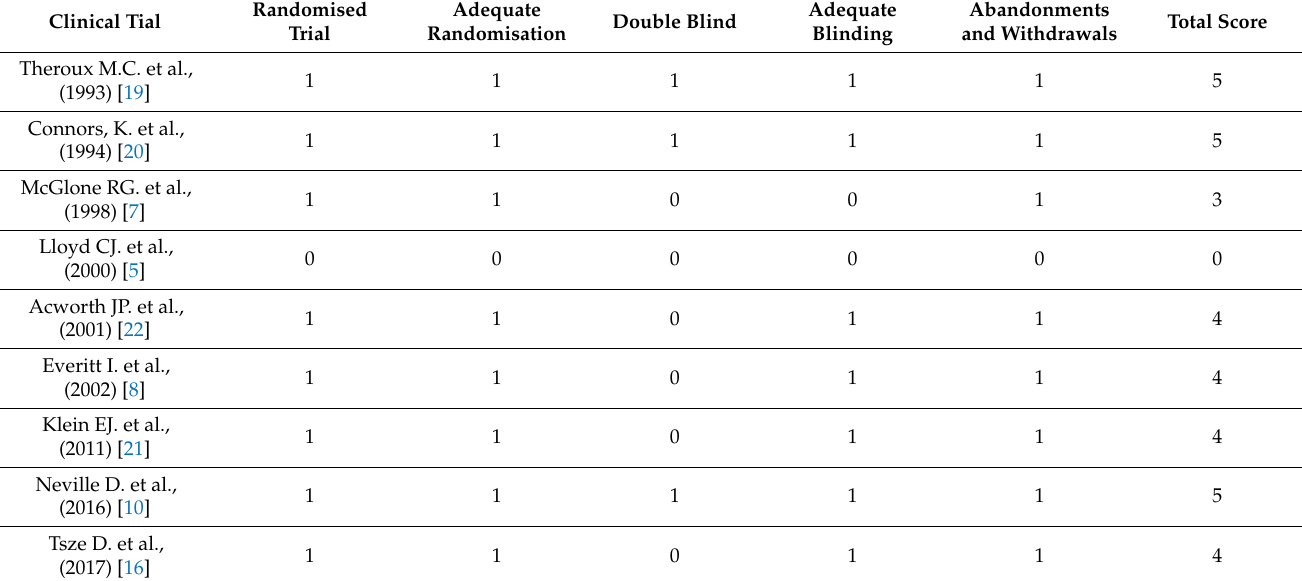
Table 4. Risk of bias and quality of the studies based on Jadad